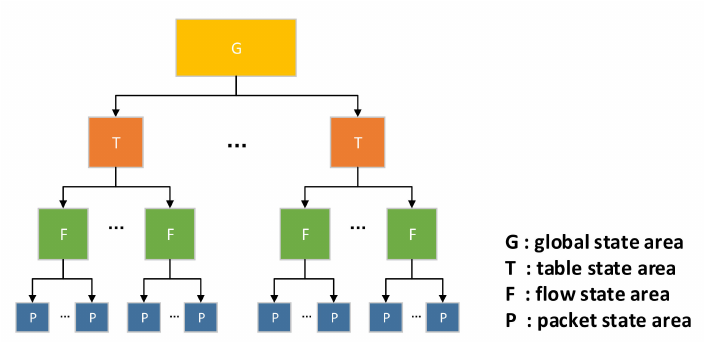
Figure 2. MSSA structure.